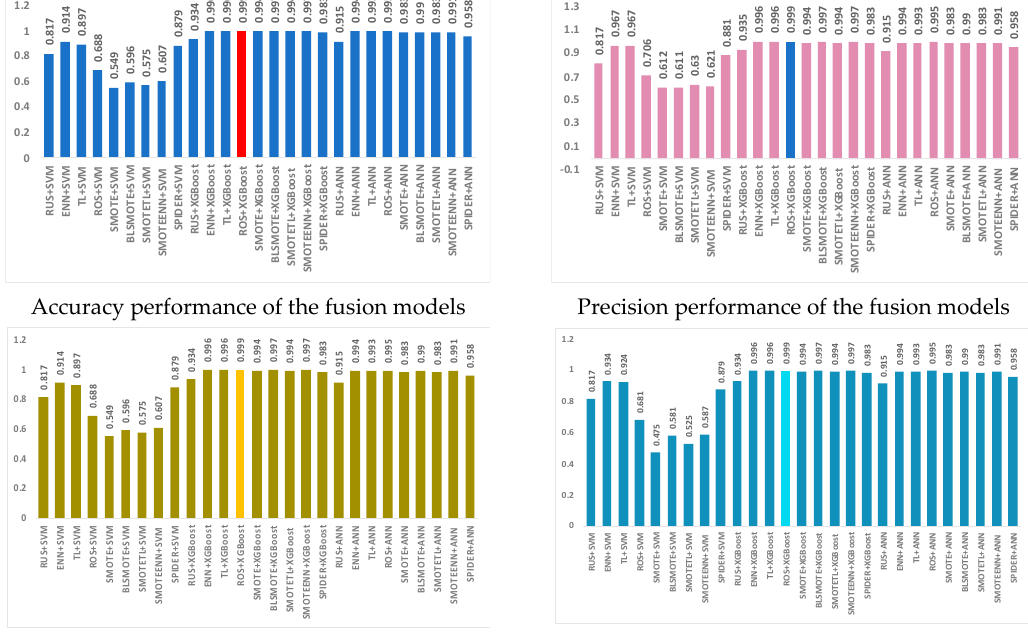
F1–score performance of the fusion models Figure 12. The overall critical performance of the fusion models. Figure 12. The overall critical performance of the fusion